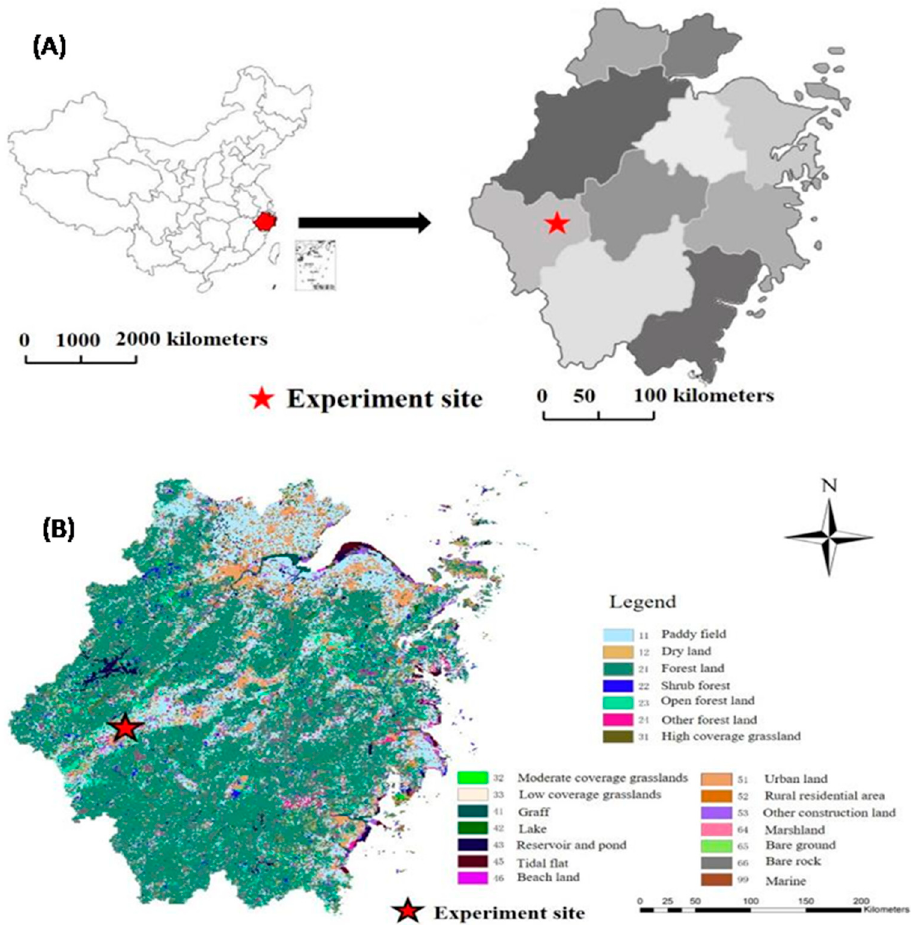
Figure 1. Geographical ( A ) and meteorological map ( B ) of the experimental site.